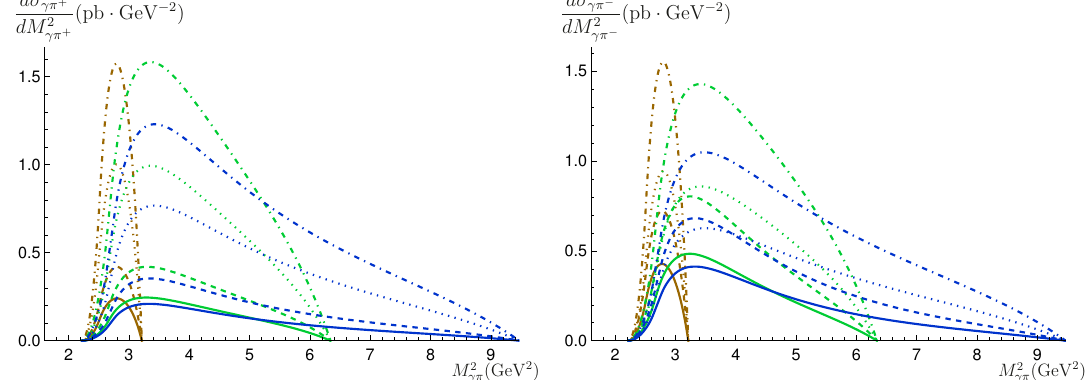
= 3 , 4 , 5 GeV 2 γπ is fixed at 20 GeV 2 . γN